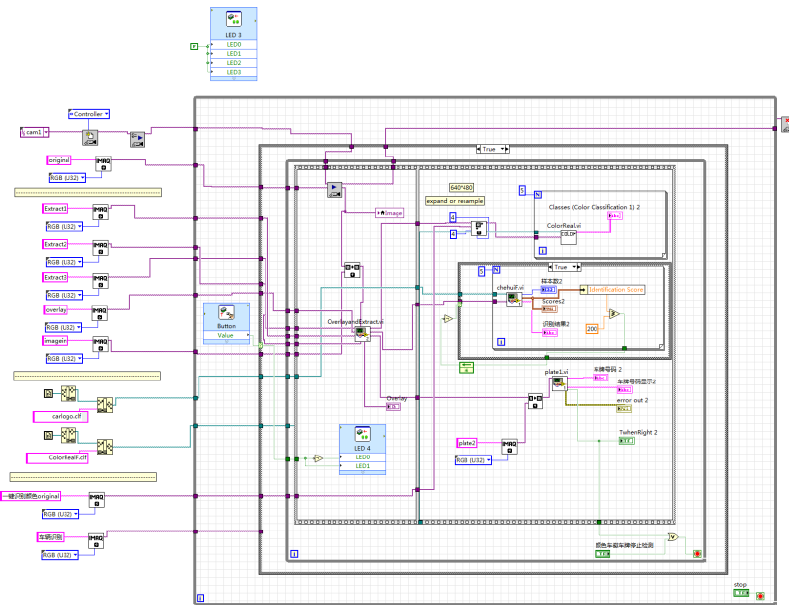
Figure 27. Overall system program block diagram.